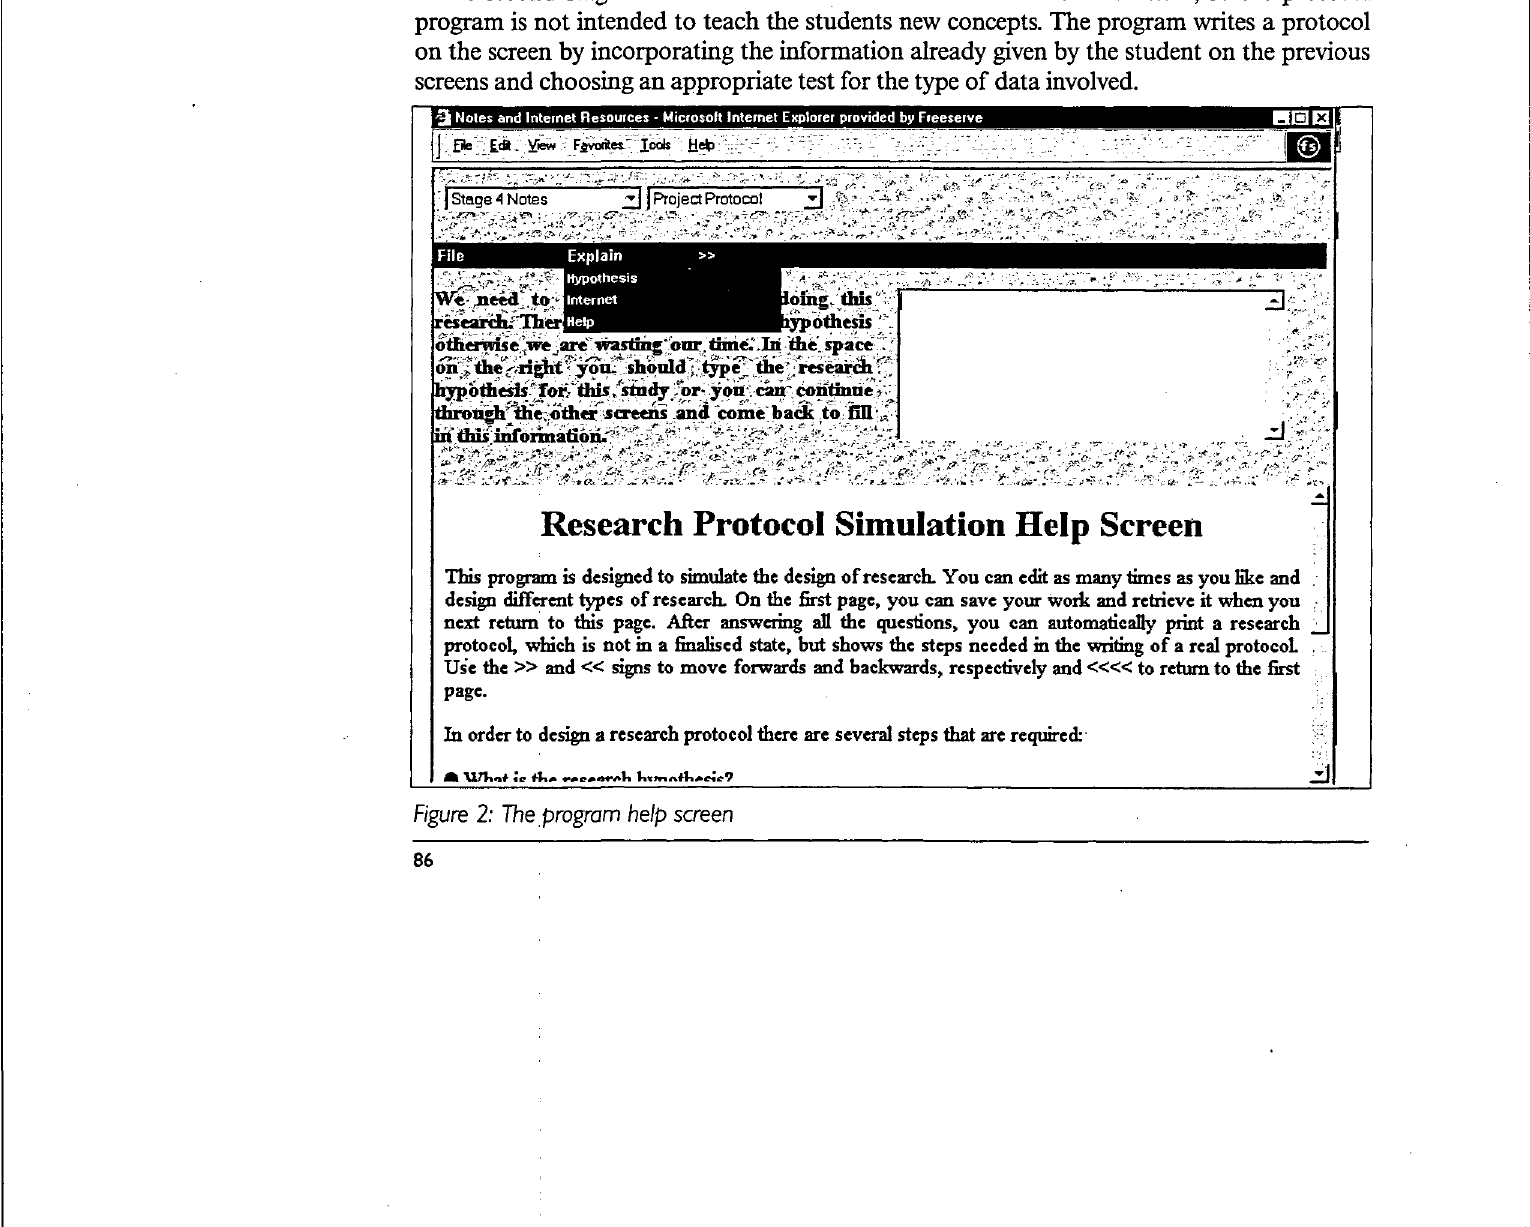
Figure 2: The program help